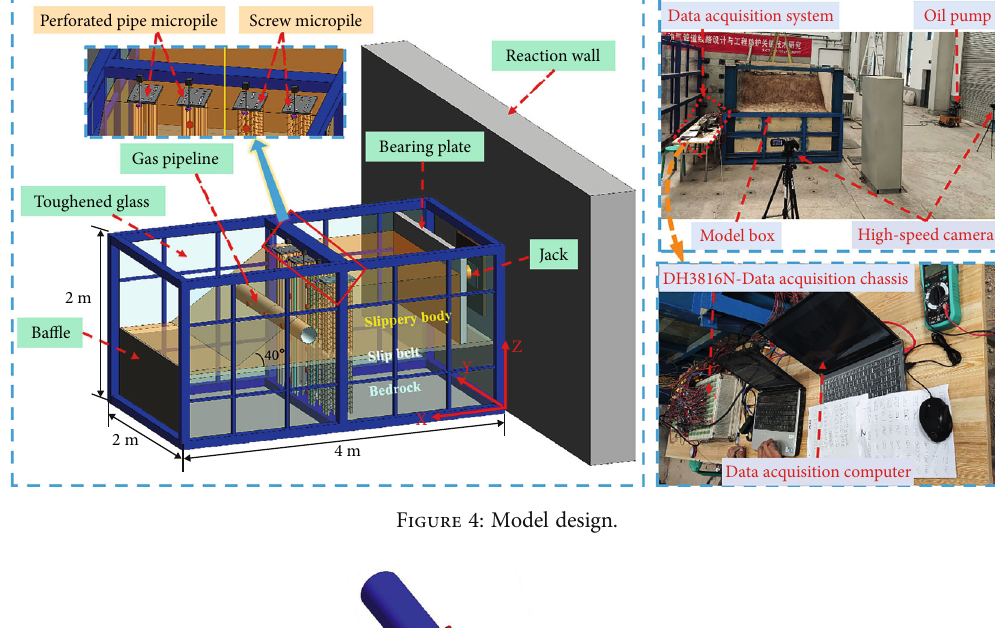
Figure 4: Model design.